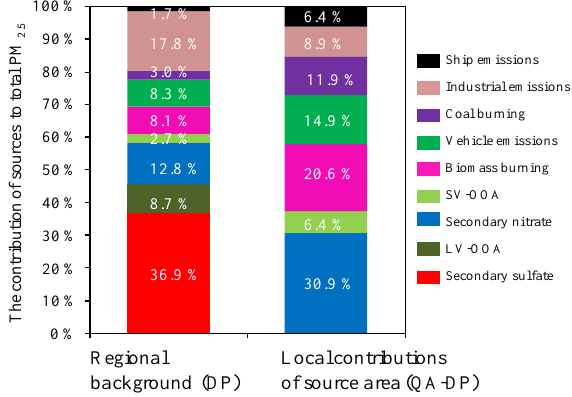
Figure 10. The PM 2 . 5 source structures in regional background air and local contributions of the central PRD area under northerly